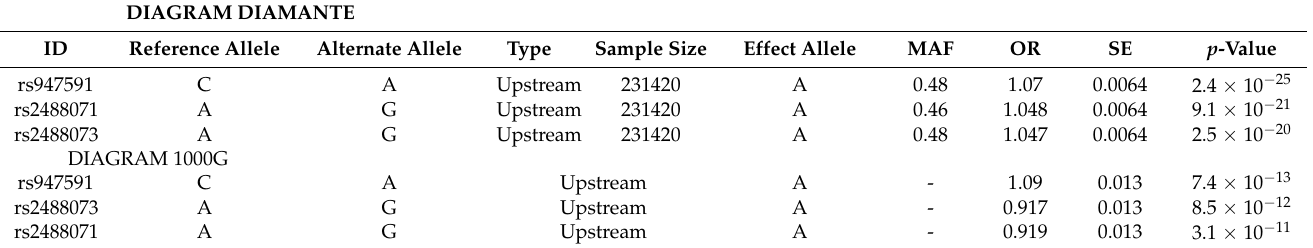
Table 2. SNPs in the proximity of EXOC6 ( ± 100 Kb) that associated with T2D in TIGER data